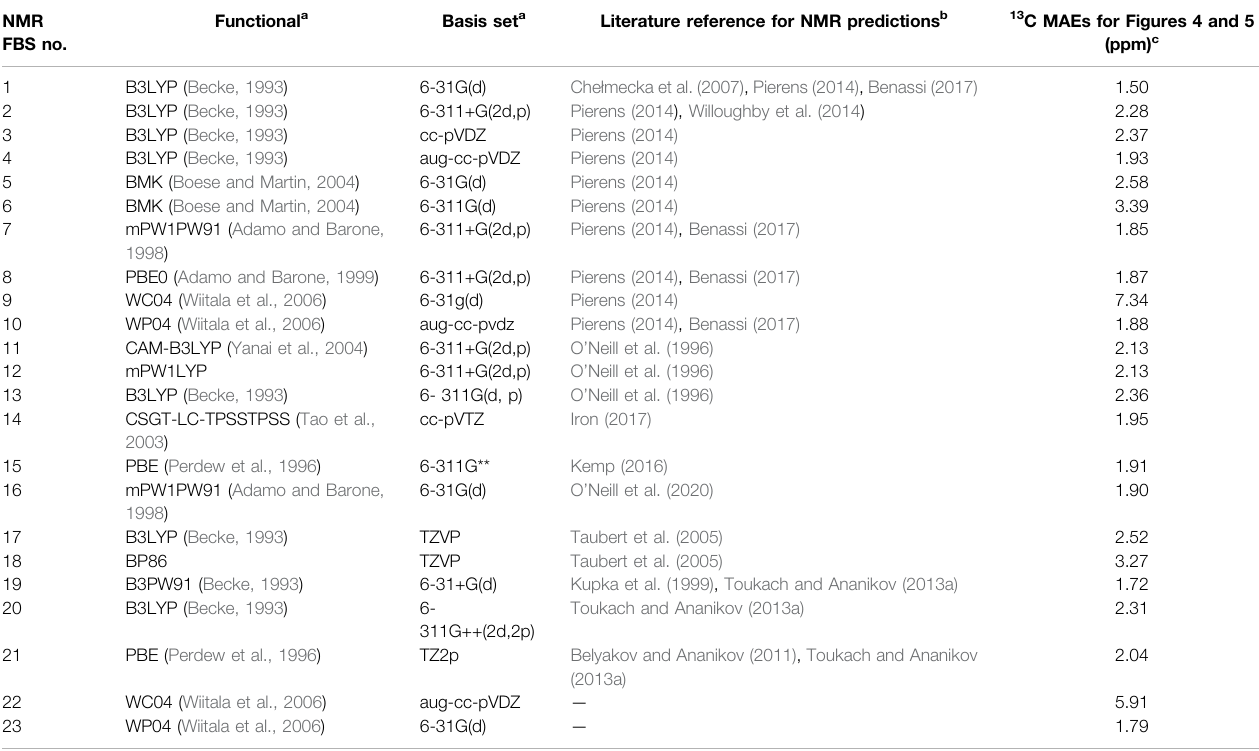
TABLE 1 | Nuclear magnetic resonance (NMR) functional – basis sets (FBS) 1 – 23 identi fi ed by their FBS combinations for NMR shielding constant calculations. NMR FBS no.